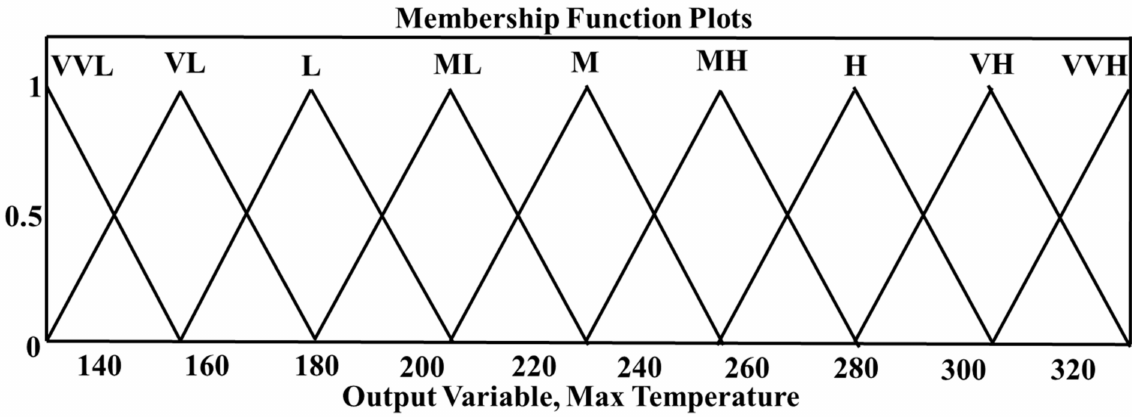
Figure 3. Output membership function used in